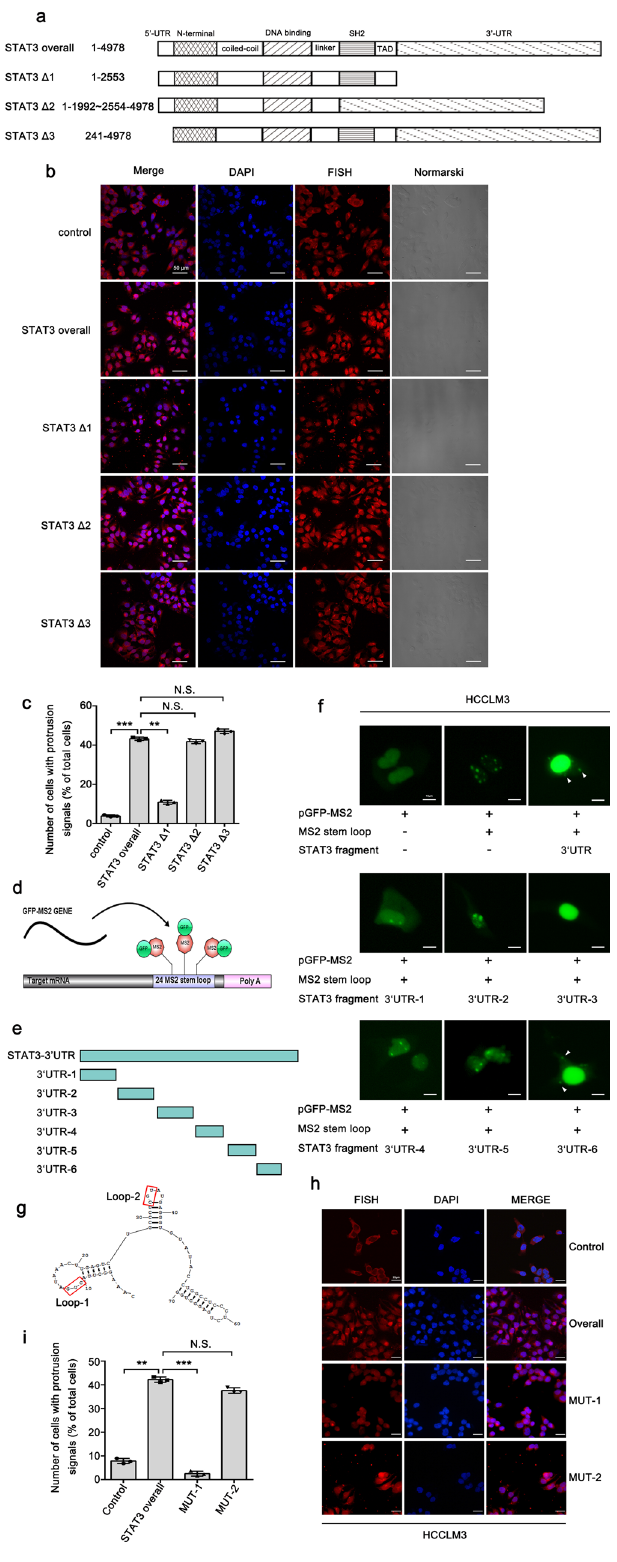
Loop-2) in the secondary structure of STAT3 3 ′ UTR-6 that may be associated with the localization of STAT3 mRNA to cell protrusions (Fig. 2g). Then, we constructed nucleotide substitu- tion mutants in the indicated sites within the two loops (MUT-1: site-mutation of Loop-1; MUT-2: site-mutation of Loop-2) and evaluated their effects on the localization of STAT3 mRNA in